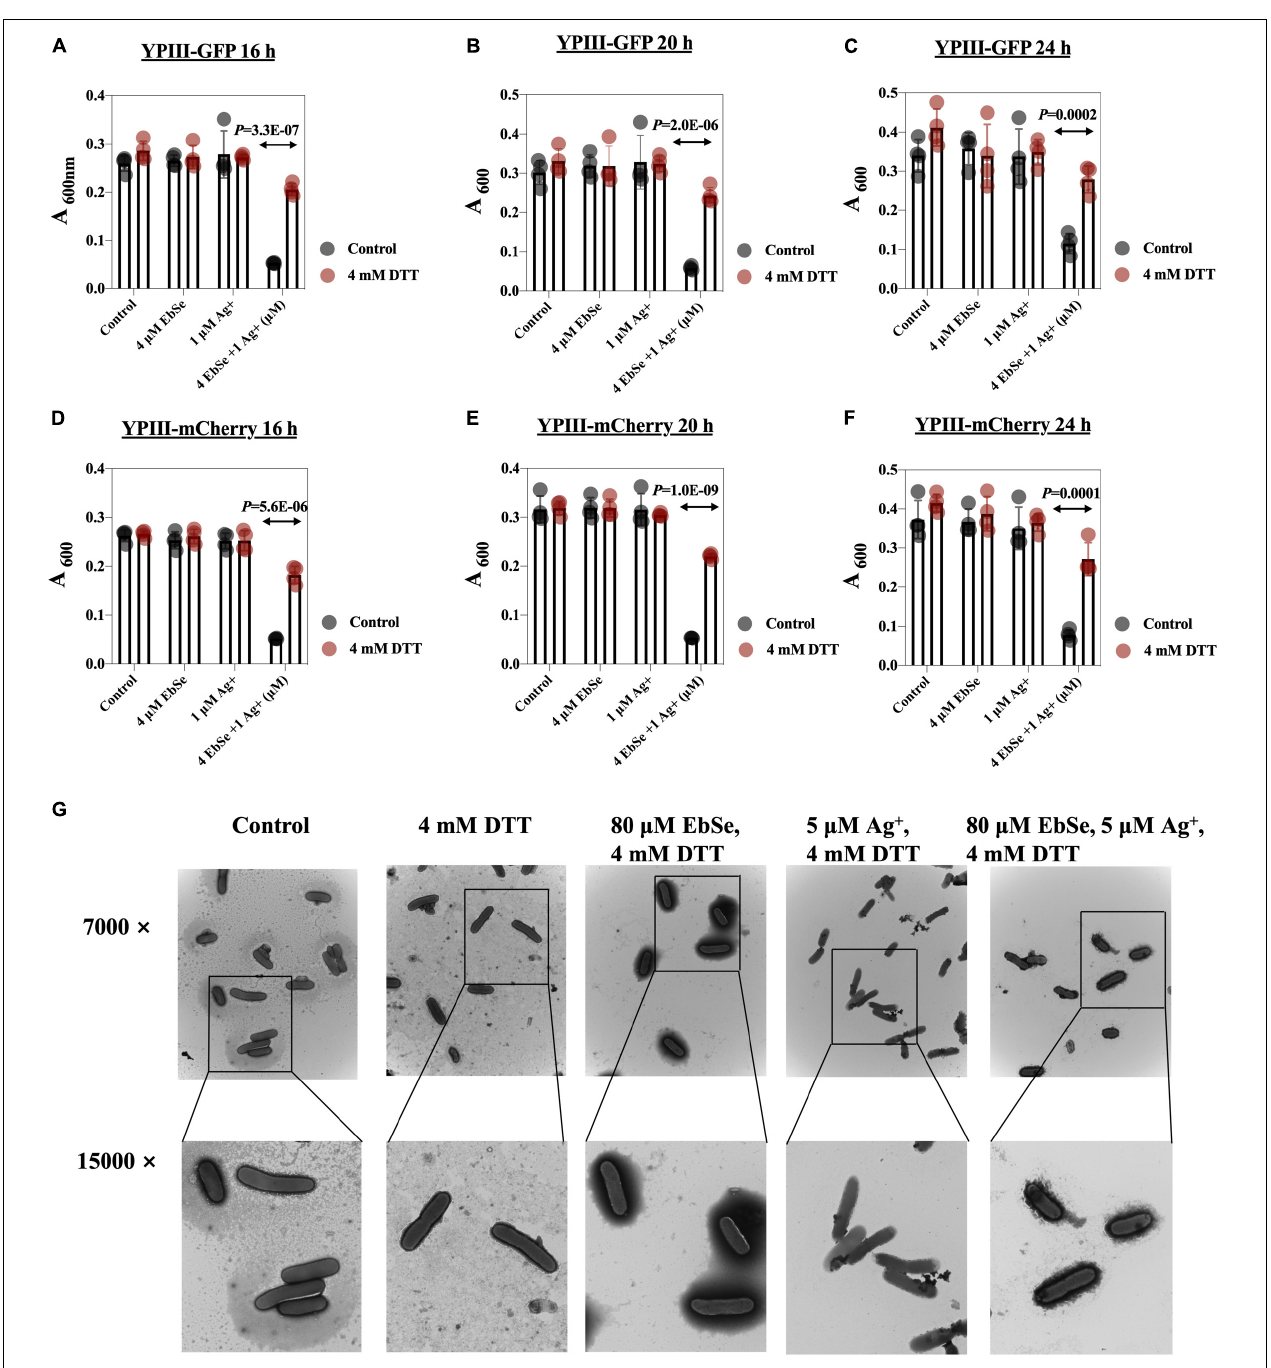
FIGURE 5 | DTT protects YpIII from EbSe-Ag + . YpIII-GFP and YpIII-mCherry were cultured to A 600 of 0.4, diluted 1:1,000 times, and treated with DTT followed with EbSe-Ag + . (A,D) At 16 h; (B,E) at 20 h; (C,F) at 24 h; (A–C) YpIII-GFP; (B–E) YpIII-mCherry. (G) YpIII-GFP was cultured to 0.4 and treated with EbSe-Ag + with DTT, and the morphological changes were observed by